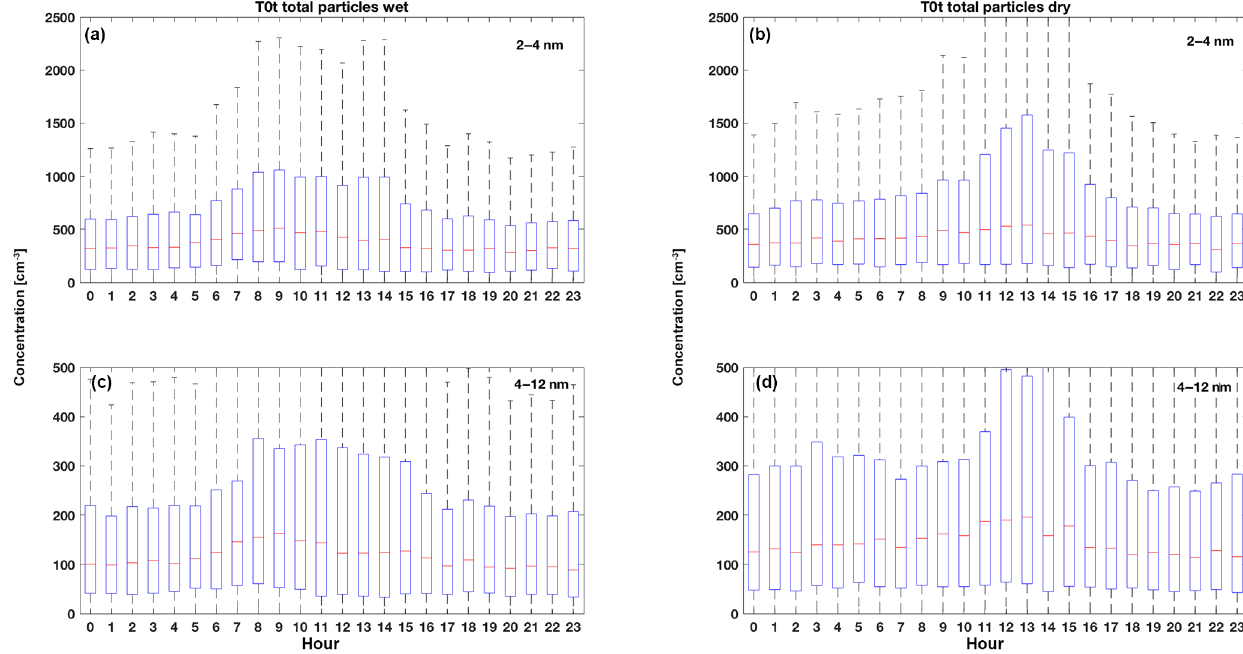
Figure 3. The median diel patterns of the intermediate (2–4nm) and the large (4–12nm) particles from the NAIS measurements at the T0t measurement site are shown. On the left-hand side are the values for the wet and on the right-hand side the values for the dry season. The boxes represent 25th–75th percentiles and the whiskers are 1 . 5 × IQR (interquartile range); data points beyond the whiskers are considered outliers.